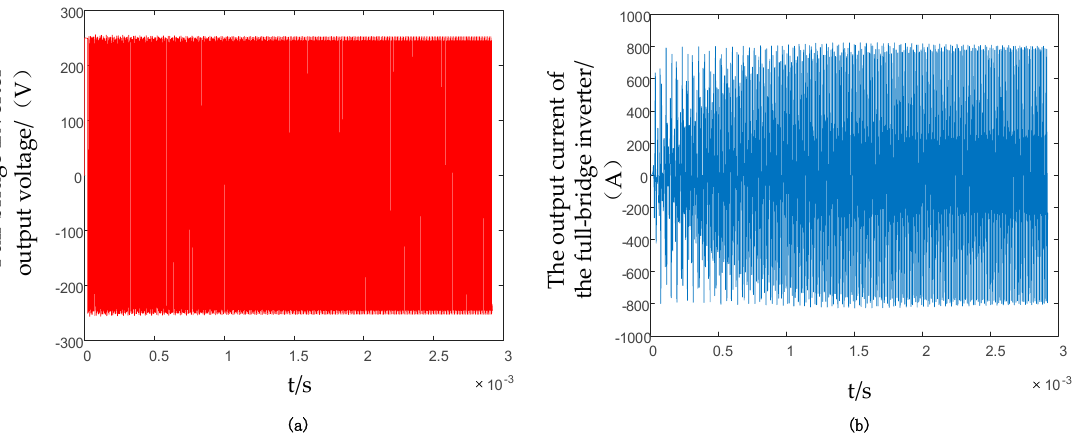
Figure 7. Simulation diagram of the output of the full-bridge inverter circuit: ( a ) the voltage simulation diagram of the result of the full-bridge inverter circuit; ( b ) current simulation diagram of creating the full-bridge inverter circuit.